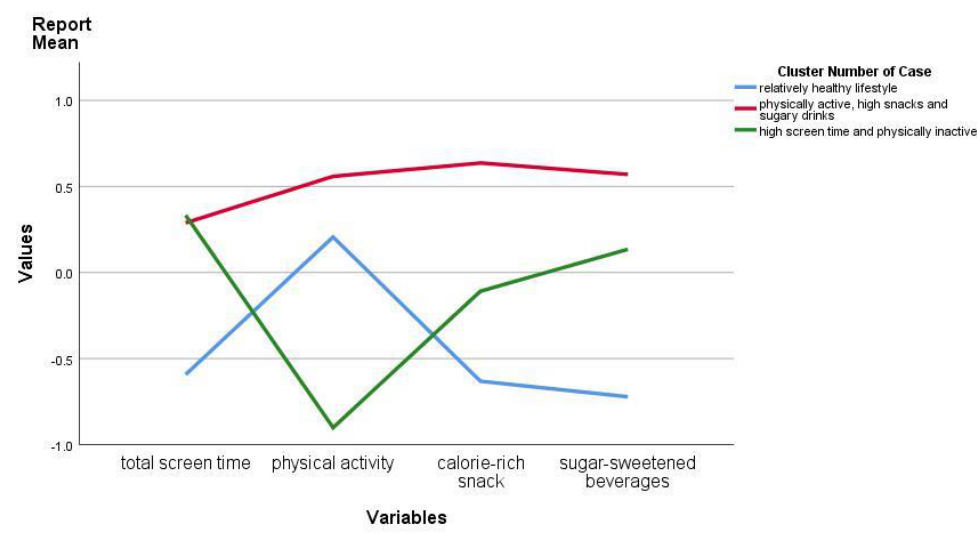
Figure 1. Z-scores of clusters on child lifestyle behaviours in participants from the Generation R Study. Table 2. Child lifestyle behaviours by cluster distribution ( n = 4059).